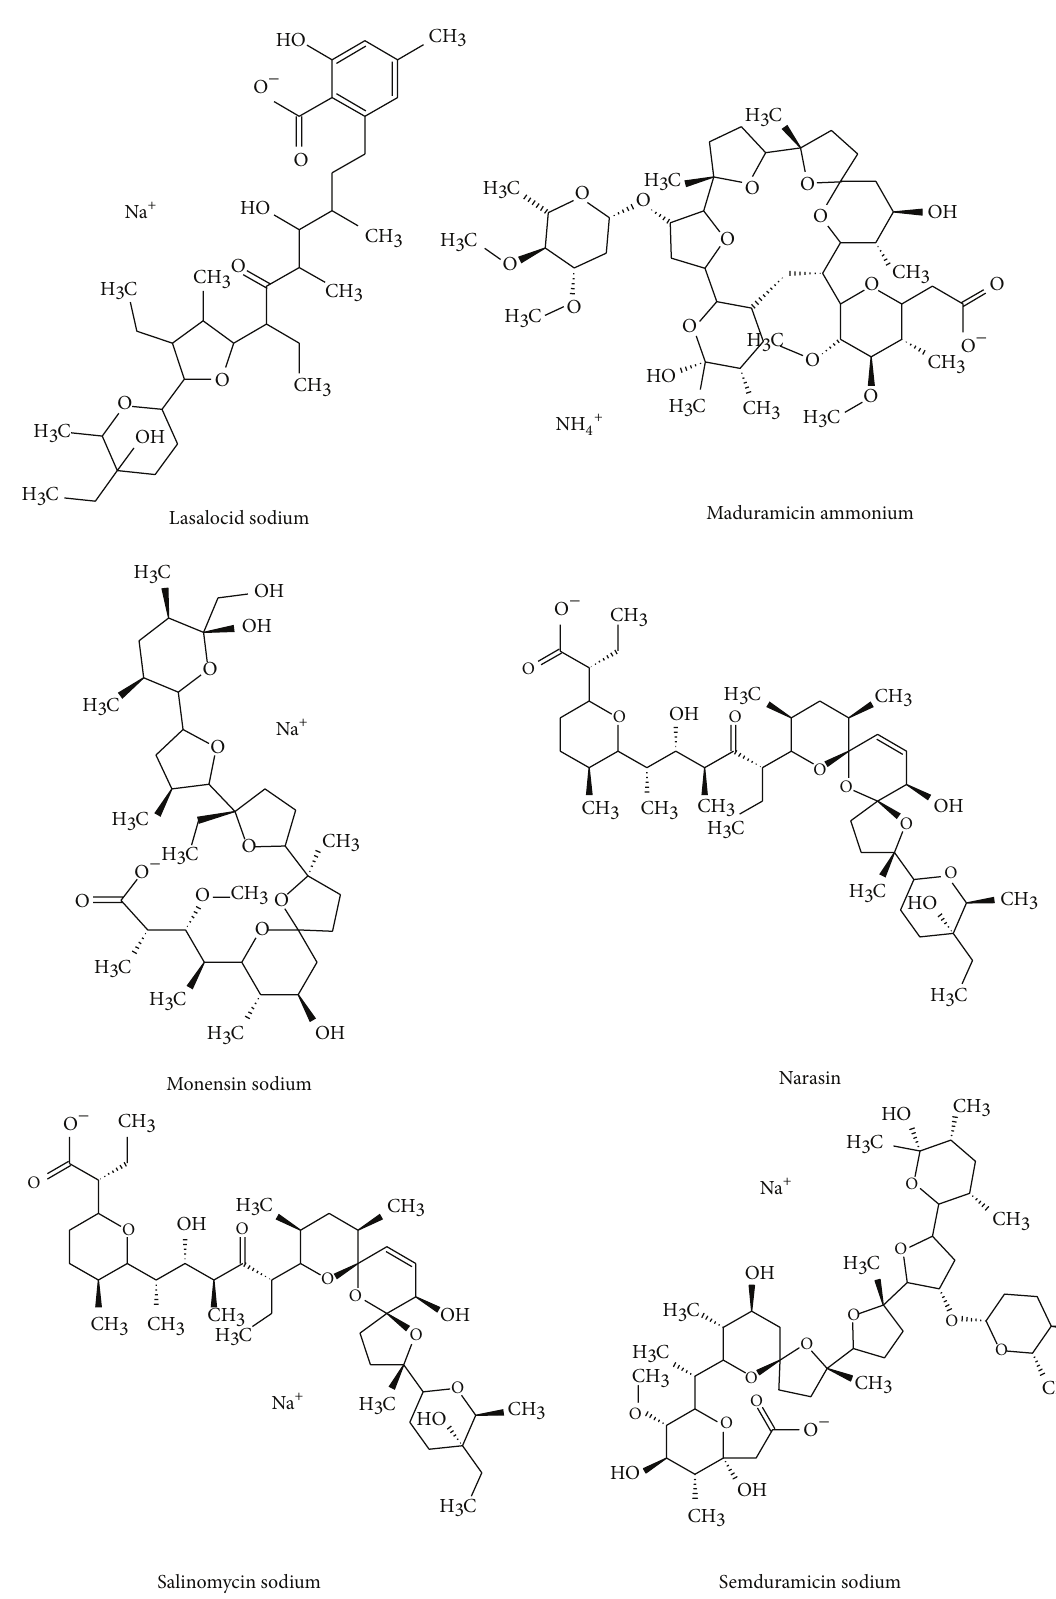
Figure 1: Chemical structures of ionophore